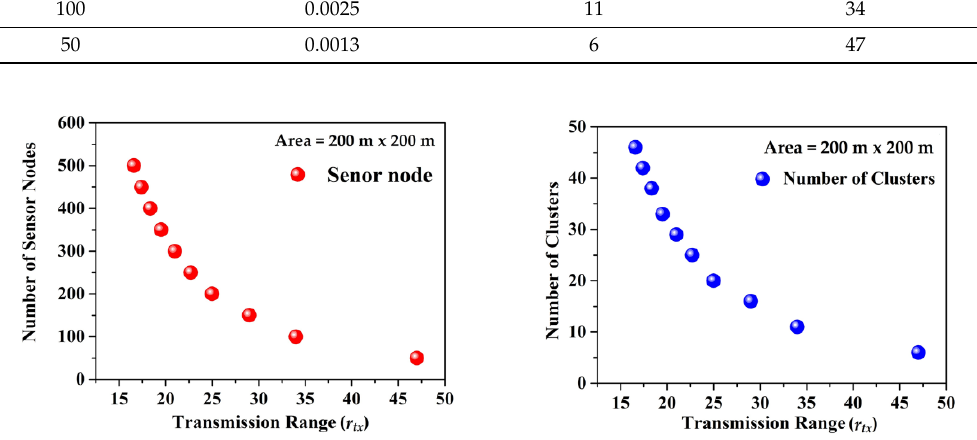
Figure 5. ( a ) The relationship between the number of sensor node and transmission range. And ( b ) the number of clusters and transmission range